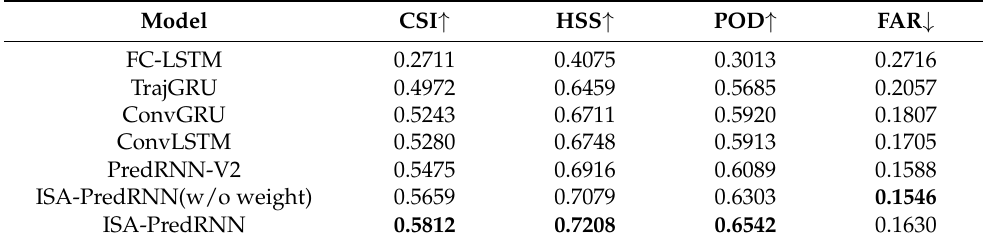
Table 2. Comparison of the experimental results at the level of 20 dBZ.